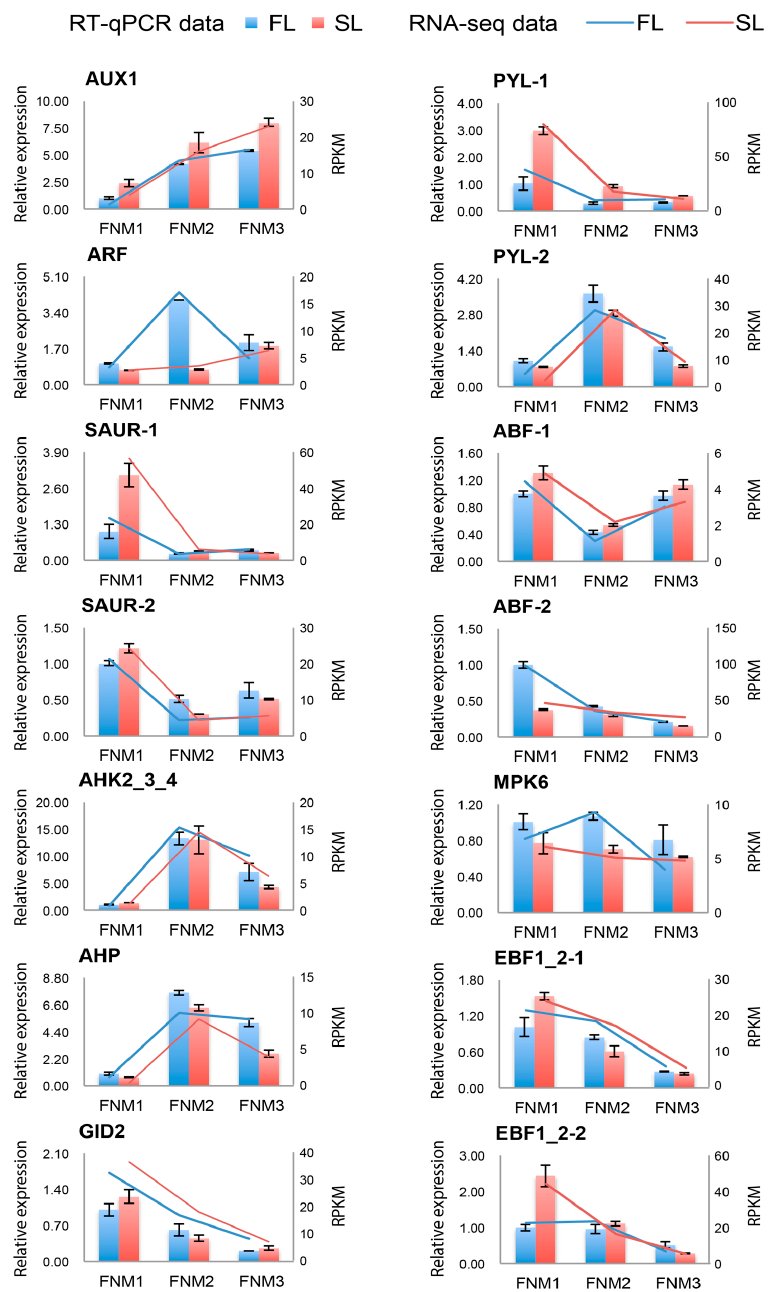
Figure 7. Candidate unigenes expression levels revealed by qRT-PCR and RNA-seq. Data from qRT-PCR are the means of three technical replicates and bars represent SE. RPKM values from RNA-seq were generated from pooled ovule samples.